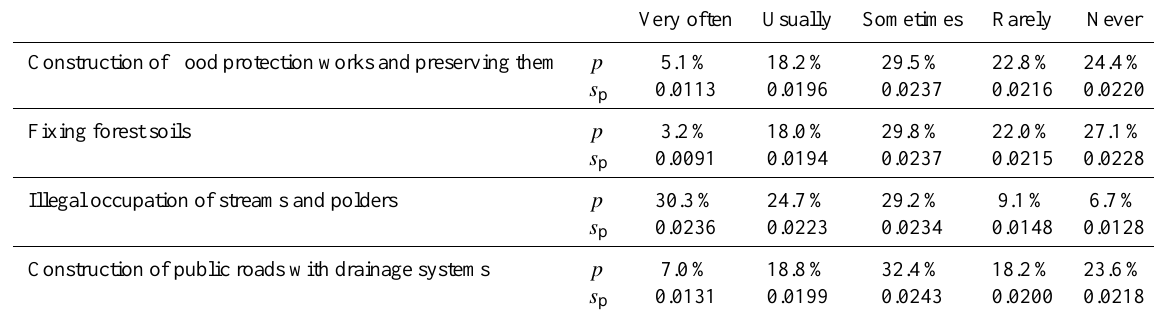
Table 5. Residents’ opinions about the activities that take place in the Sporades islands regarding snow/frost consequences.